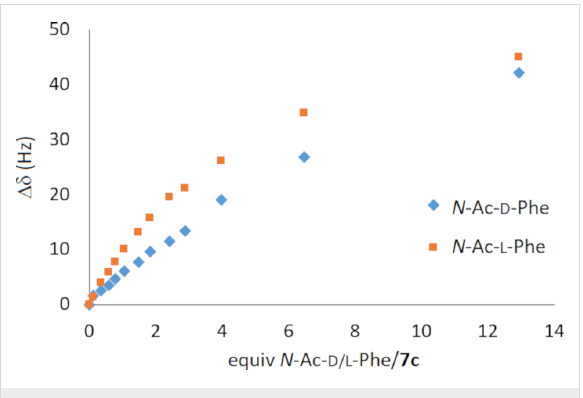
Figure 5: 1 H NMR titration of 7c with N -acetyl- ᴅ -phenylalaninate and N -acetyl- ʟ -phenylalaninate (as TBA salts, 400 MHz, 298 K, DMSO- d 6 , the aromatic signal of the calixarene moiety was